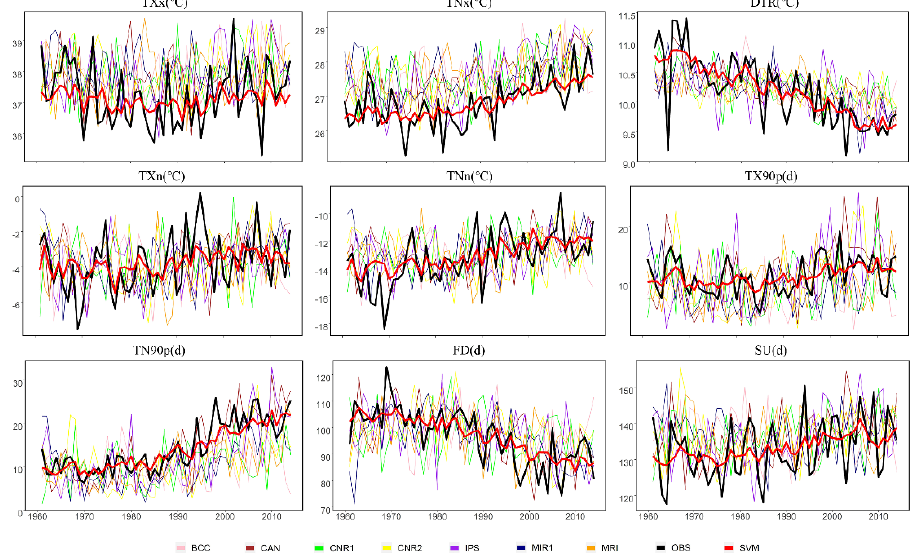
Figure 2. Trends in observed and simulated nine extreme temperature indices in the North China Plain from 1961 to 2014. Table 3. Root mean square error (RMSE) and relative standard deviation (RSD) between simulations and observed values for the nine extreme temperature indices.